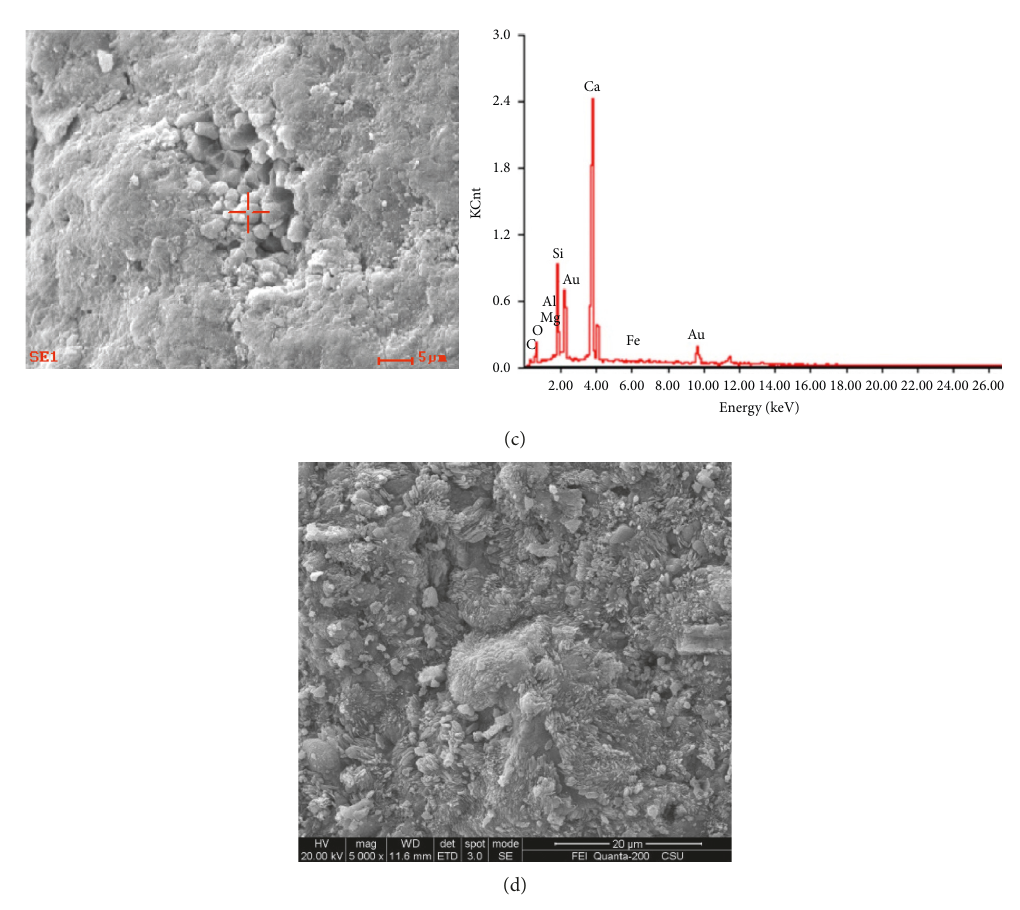
Figure 5: ESEM-EDS spectrum of samples under different temperatures. (a) Noncarbonation. (b) 10 ° C. (c) 20 ° C. (d) 30 °